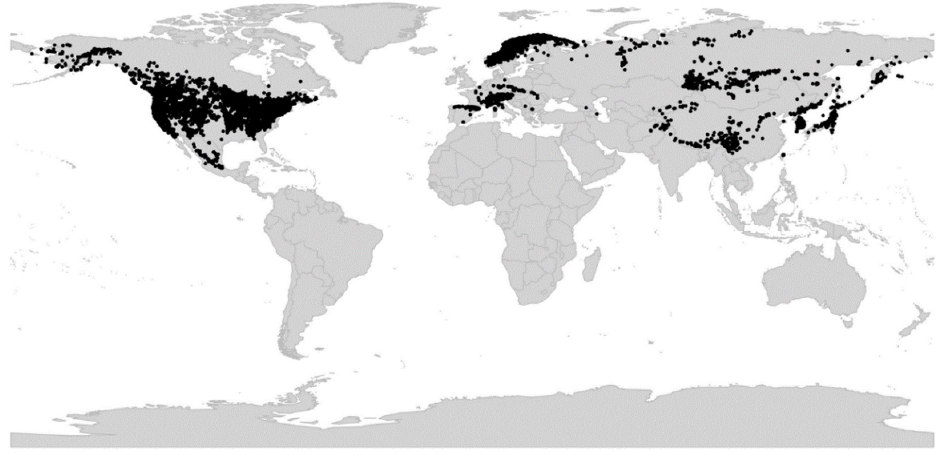
Figure 12. Global distribution of Viola sect. Chamaemelanium .